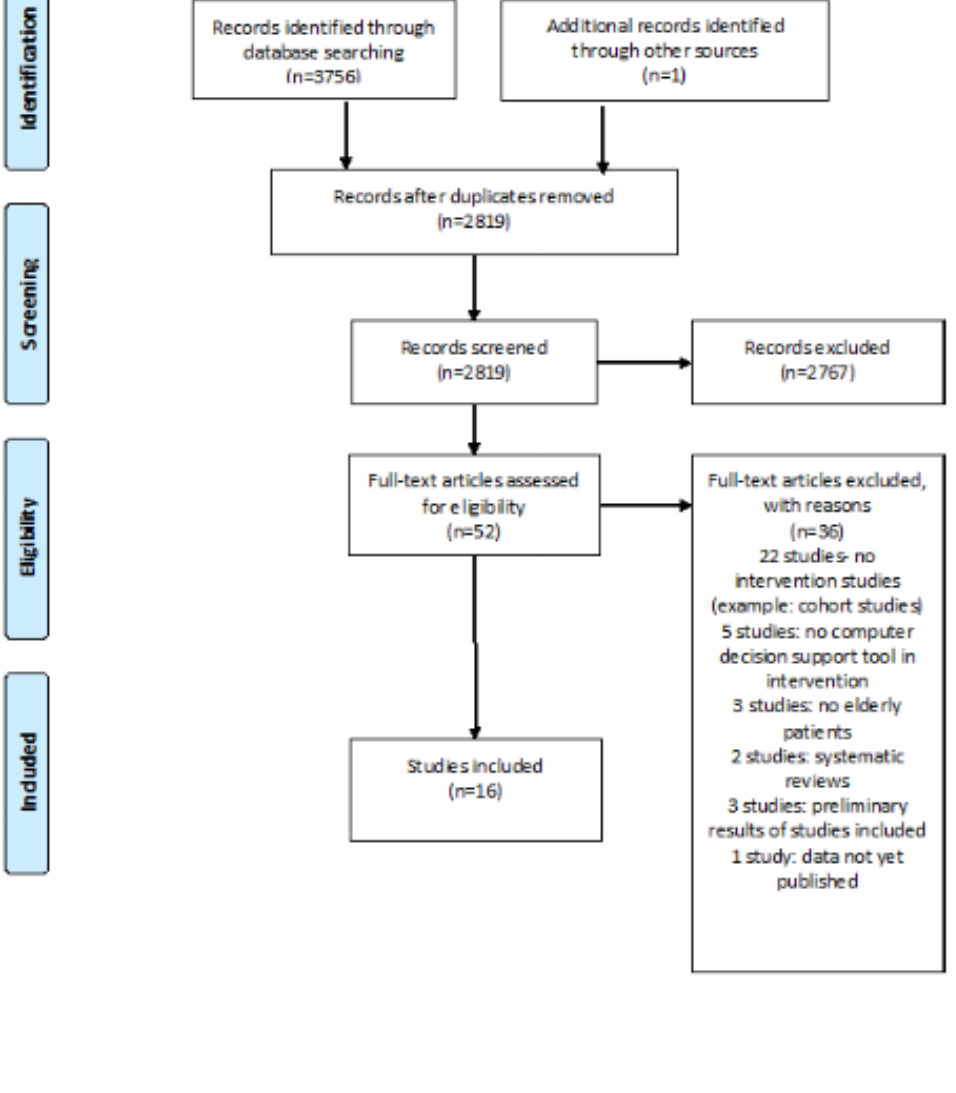
Figure 1. Flow diagram on search and article inclusion, according to the Preferred Reporting Items for Systematic Reviews and Meta-Analyses (PRISMA)